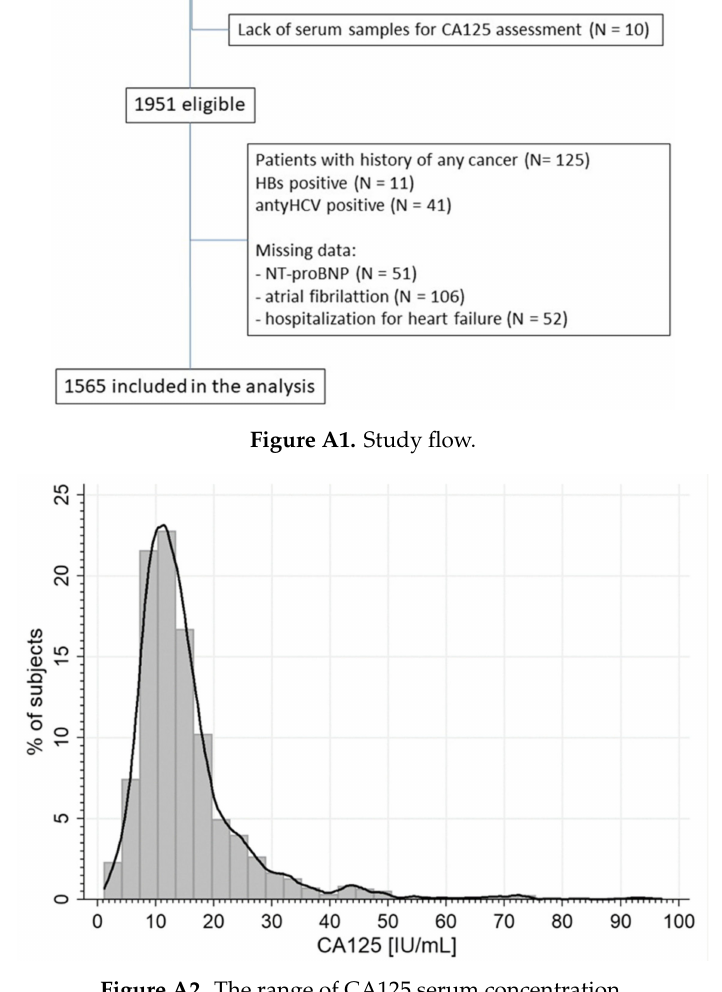
Figure A2. The range of CA125 serum